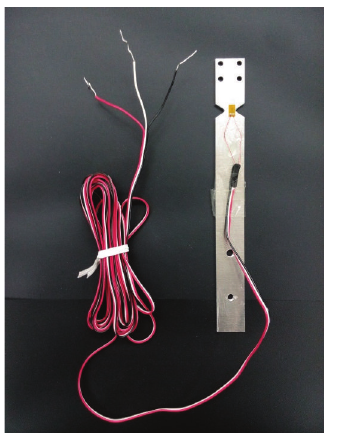
Figure 3: Fixture and specimen. Figure 4: Specimen and strain